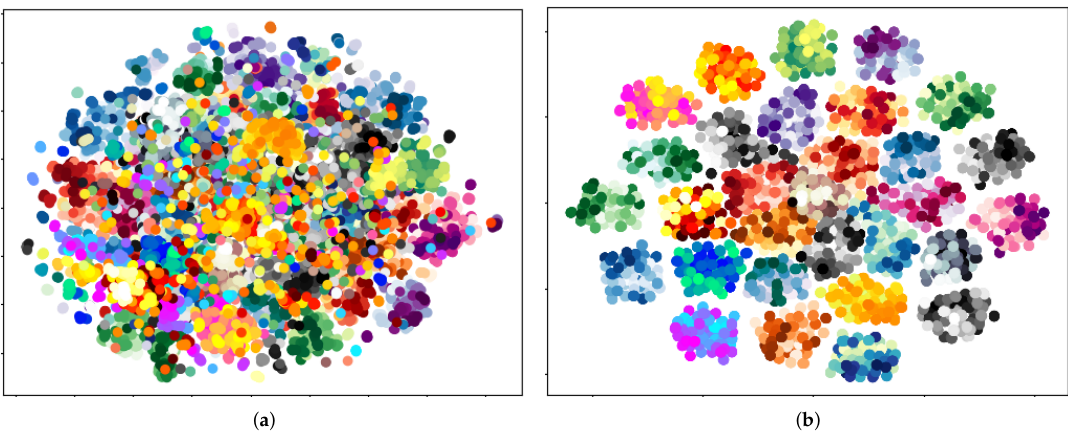
Figure 6. Visualizing average embeddings vs. Supervectors for 30 phrases from females using t-SNE. Each phrase is marked by one different color scale. ( a ) average embeddings; ( b )